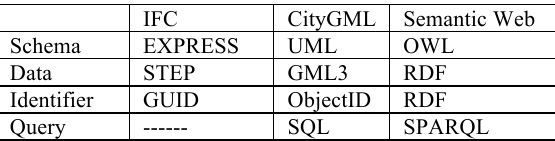
Table 1. Characteristics of IFC, CityGML and Semantic Web